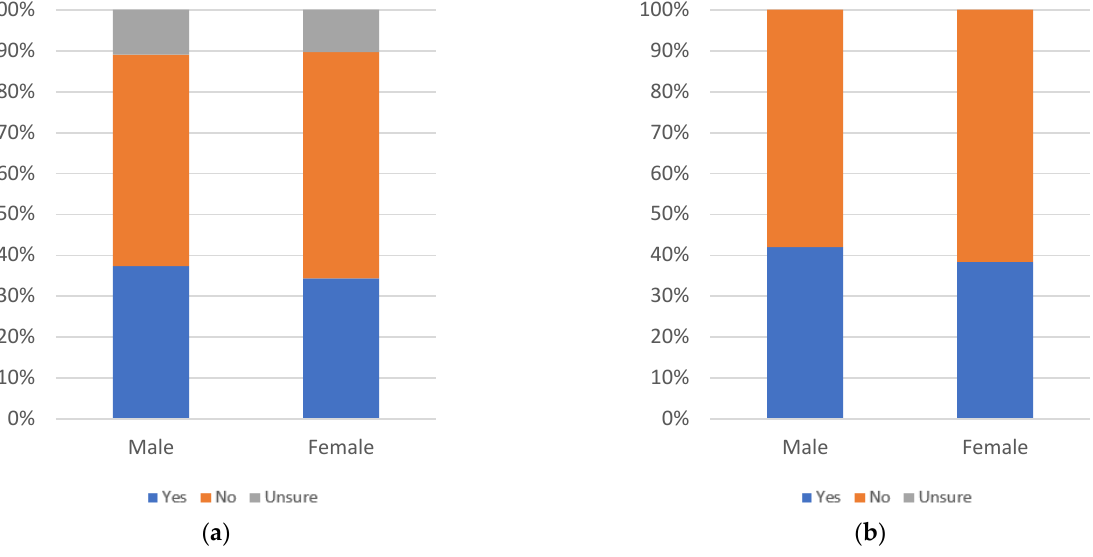
Figure 74. Label annoyingness, by gender: ( a ) with uncertain respondents (left) and ( b ) without uncertain respondents (right).